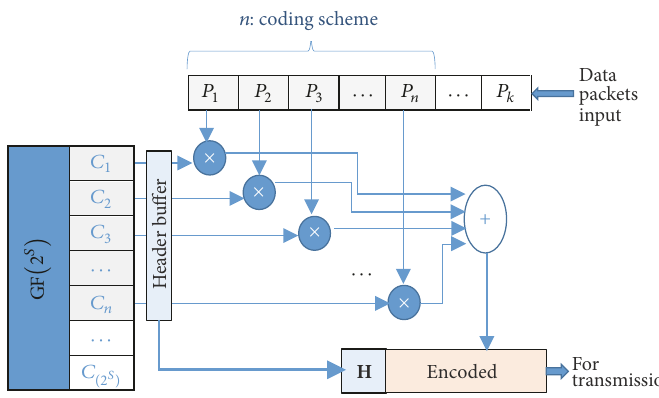
Figure 1: RLNC network coding process [6].